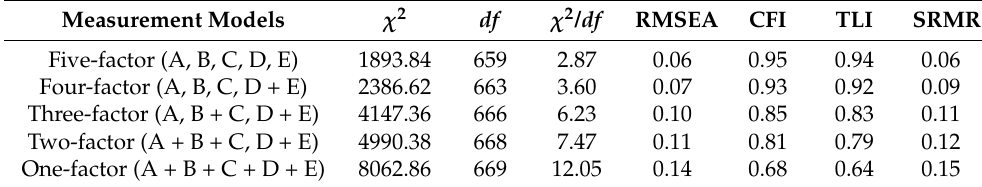
Table 1. Results of confirmatory factor analysis of the measurement